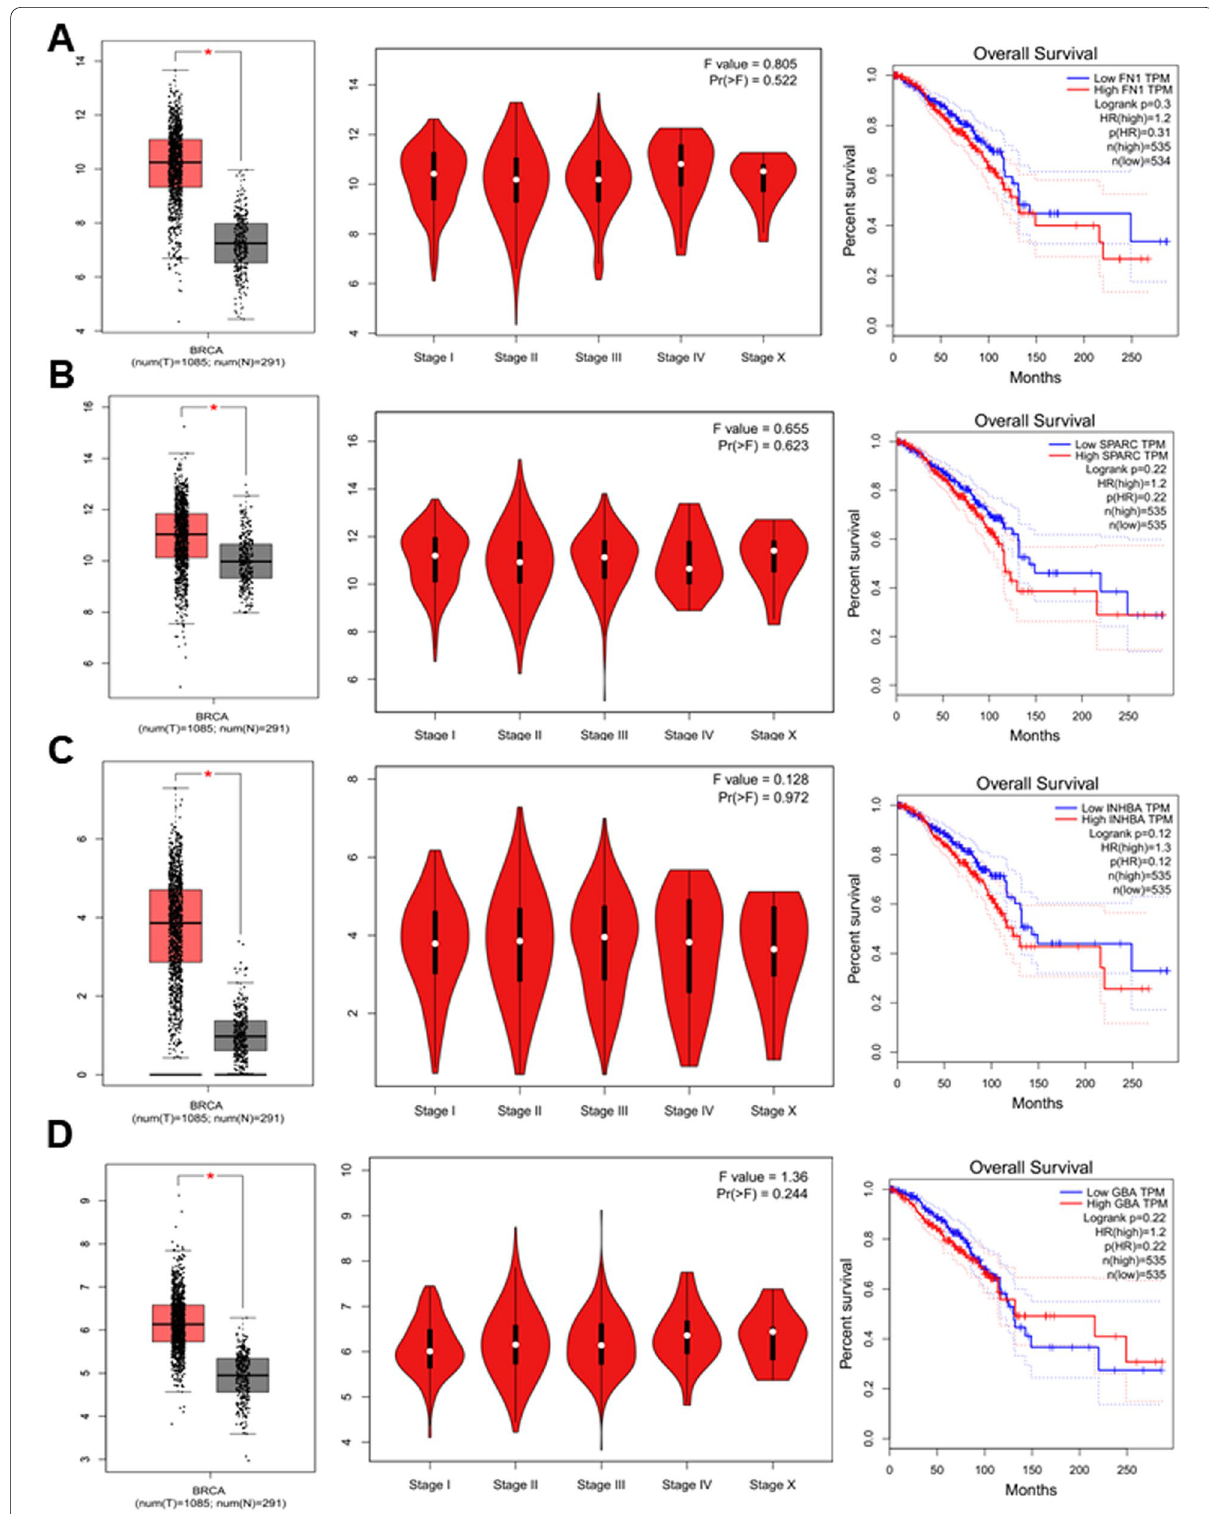
Fig. 5 (See legend on previous